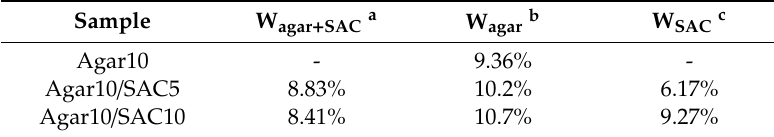
Table 1. Calculation of the composition of the agar and SAC in an agar/SAC composite gel based on TGA analysis.